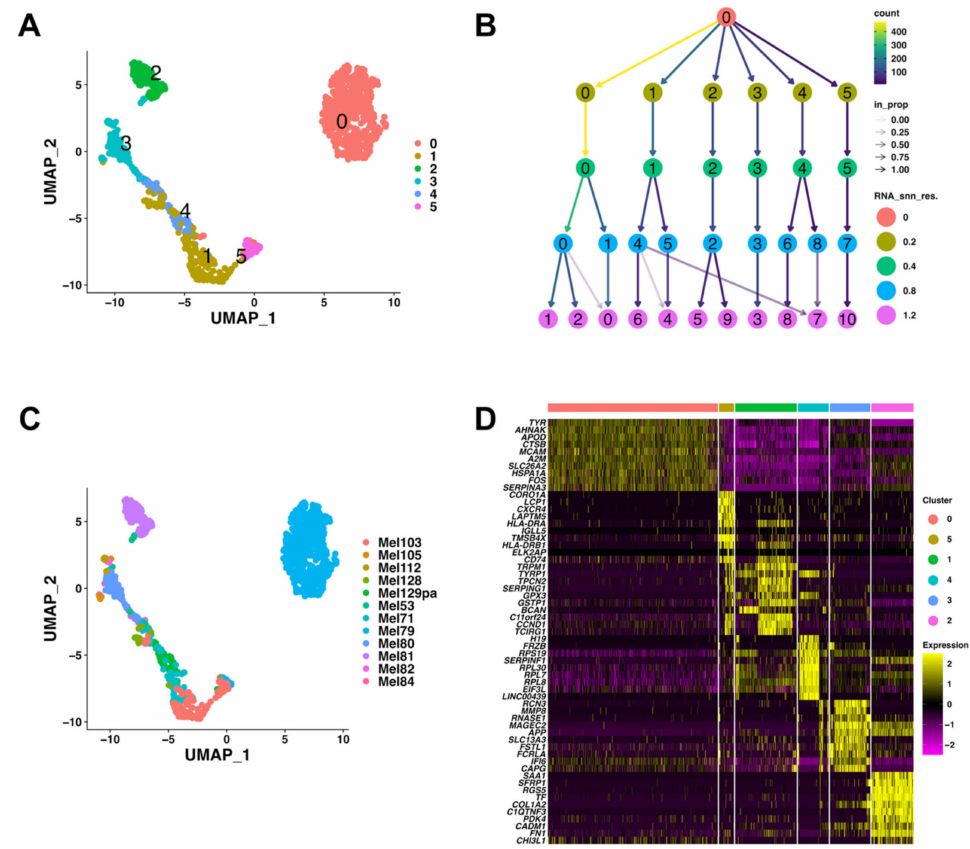
Figure 1. Melanoma patients exhibited different genetic profiles on the scRNA transcriptome level. ( A ) UMAP plot of 981 melanoma cells aggregated in six Louvain clusters. ( B ) Clustering tree for the melanoma cells clustered using various resolution parameters (0, 0.2, 0.4, 0.8, and 1.2). ( C ) UMAP plot showing patient sample distribution among the melanoma clusters. ( D ) The top 10 DEGs of each melanoma cell cluster are visualized by a